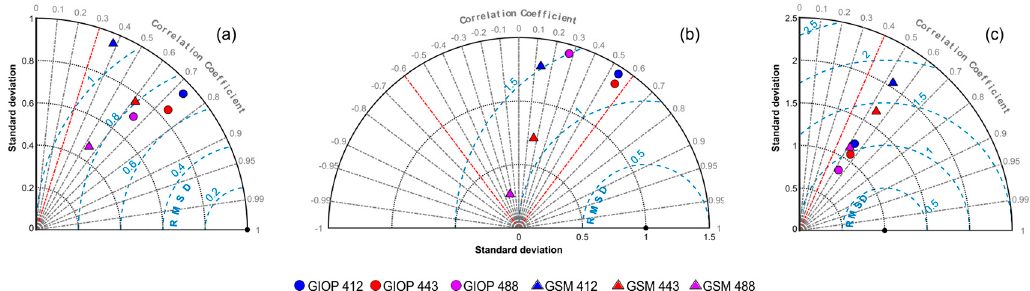
Figure 8. Taylor diagram illustrating the relative performance of the algorithms GIOP and GSM in reproducing the absorption coefficient a dg (412, 443, and 488 nm). Each diagram represents the analysis applied to ( a ) all of the data and by bio-optical regions ( b ) UGC and ( c ) NGC. The dotted red line represents the critical value of Pearson’s correlation coefficient.